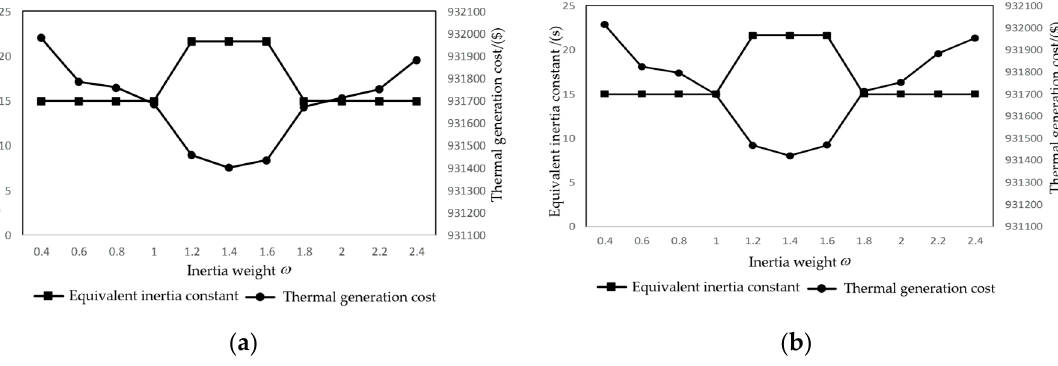
Figure 10. ( a ) Objective results with random members generated by uniformly random sampling; ( b ) objective results with random members generated by Monte Carlo sampling.